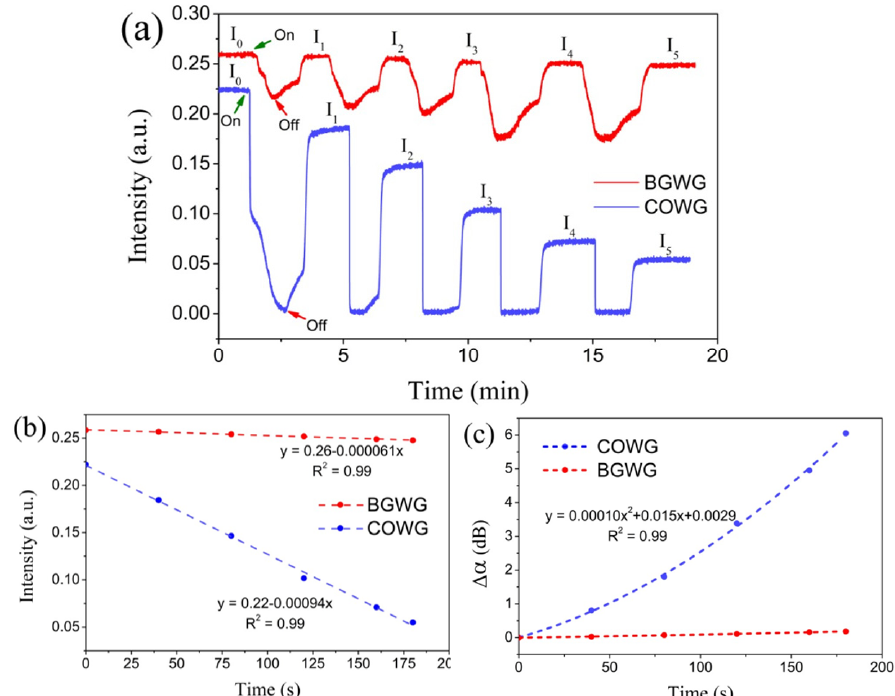
Figure 10. Experimental results: ( a ) temporal responses of the COWG and BGWG to step-by-step aerosol salt deposition with the same salt aerosol (deposition time 40 s each step); ( b ) output light intensities of the COWG and BGWG versus the accumulated deposition time; ( c ) the attenuation variation Δα for the COWG and BGWG versus the accumulated deposition time.